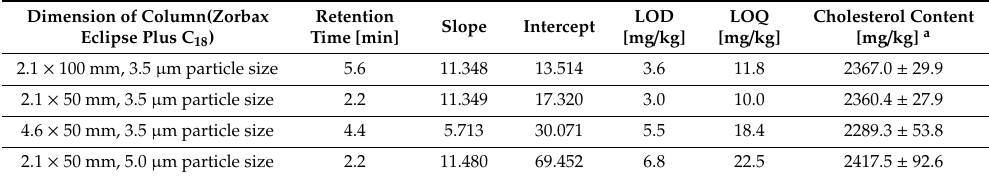
Table 2. The ruggedness of proposed